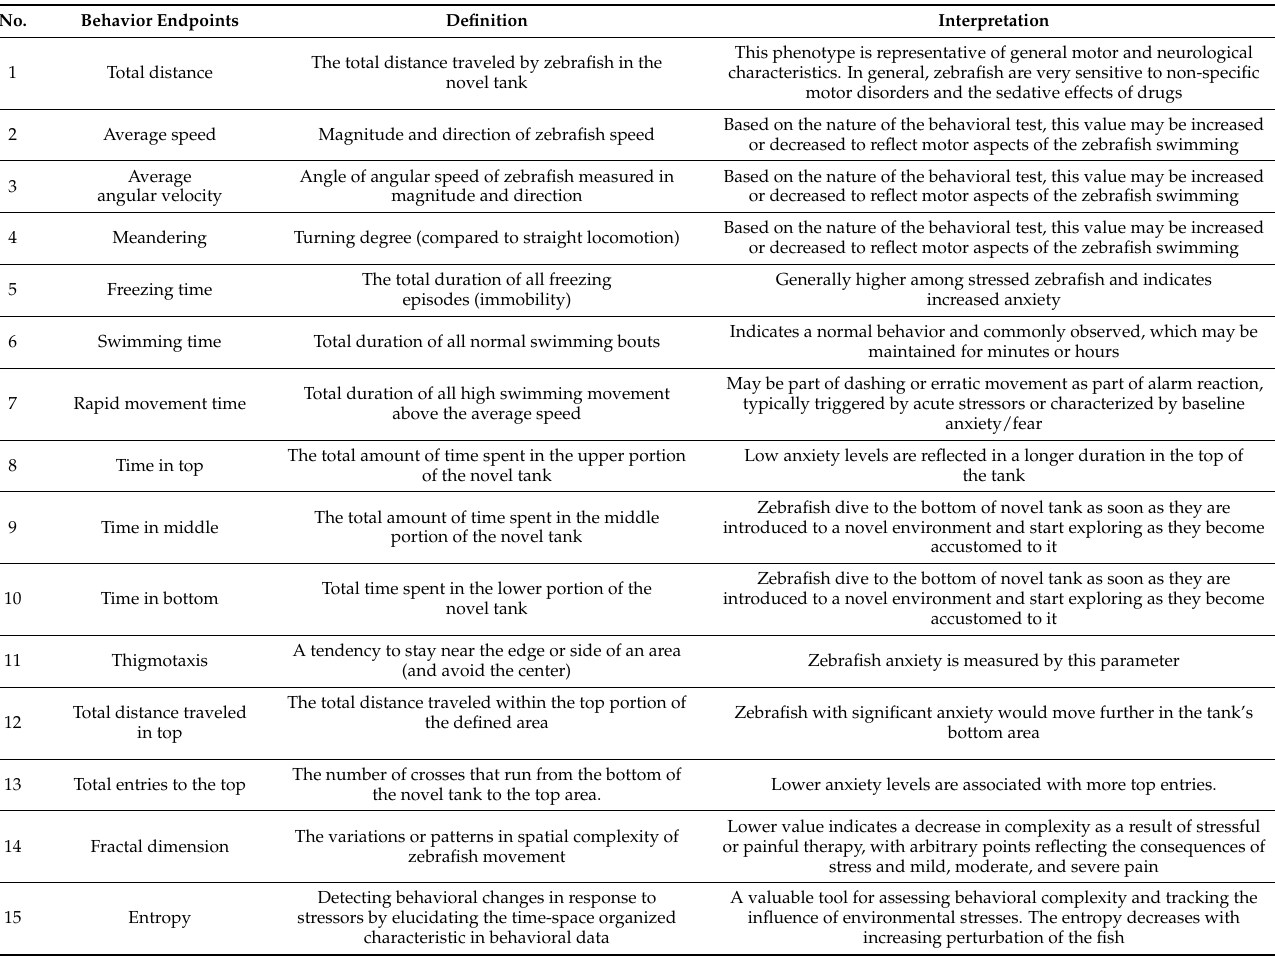
Table A2. Summary of all endpoints used to generate data matrix to conduct PCA and